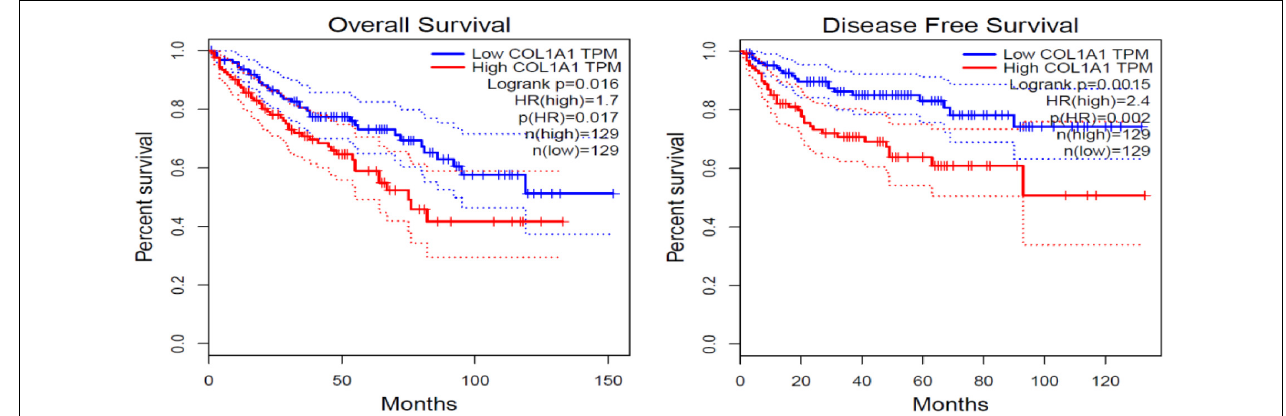
FIGURE 2 | The impact of tumor fibrosis on the disease-free survival of ccRCC patients in the PKUPH cohort.